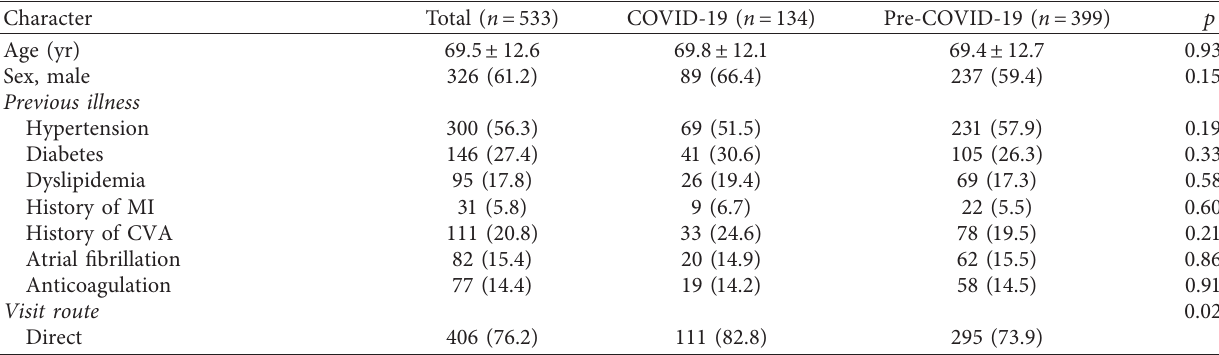
Figure 2: Flowchart of the study patients. Table 1: Demographic and clinical characteristics of patients diagnosed with acute ischemic